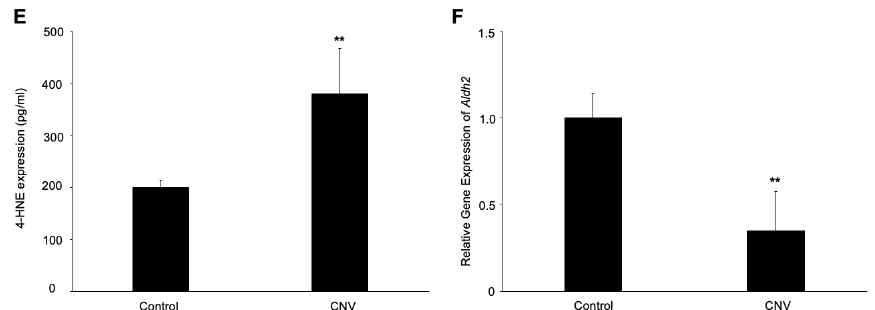
Figure 1. Immunofluorescence images of the isolectin B4-stained RPE/choroidal flat-mount of laser- induced CNV mice. ( A , B ) Labeling of isolectin B4 (green) in eyes with CNV from mice at post-laser day 7. ( C ) Phase-contrast image of CNV section. ( D ) Immunofluorescence image of CNV section. Scale bar, 20 μm. ( E ) 4-HNE expression levels in RPE/choroidal complex at post-laser day 7. ( F ) Aldh2 gene expression levels in RPE/choroidal complex at post-laser day 7. n = 6 in each group. ** p < 0.01.